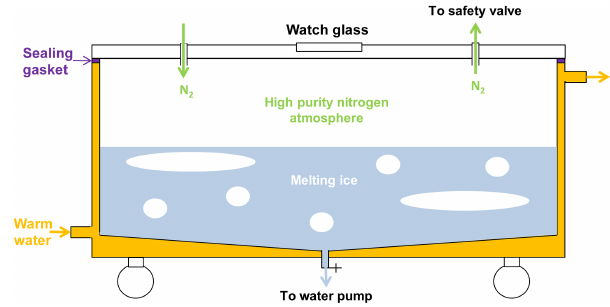
Figure 2. Conceptual cross-sectional diagram of the ice-melting unit used in this